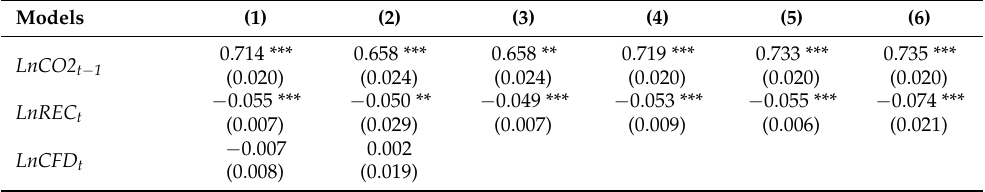
Table A2. Results of GMM model with LnREC and without the squared term of financial